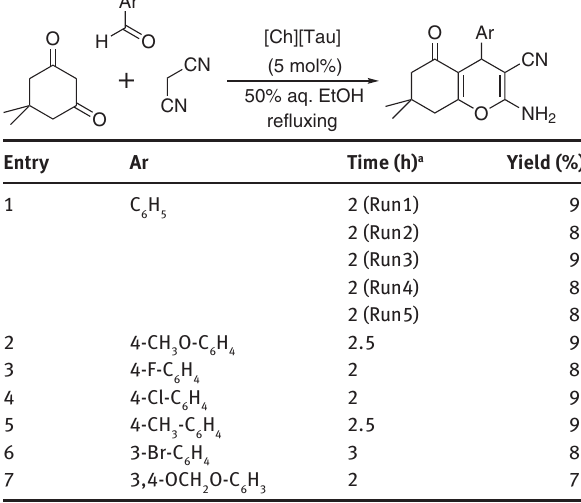
Table 3: Synthesis of 4 H -benzo[b]pyrans catalyzed by